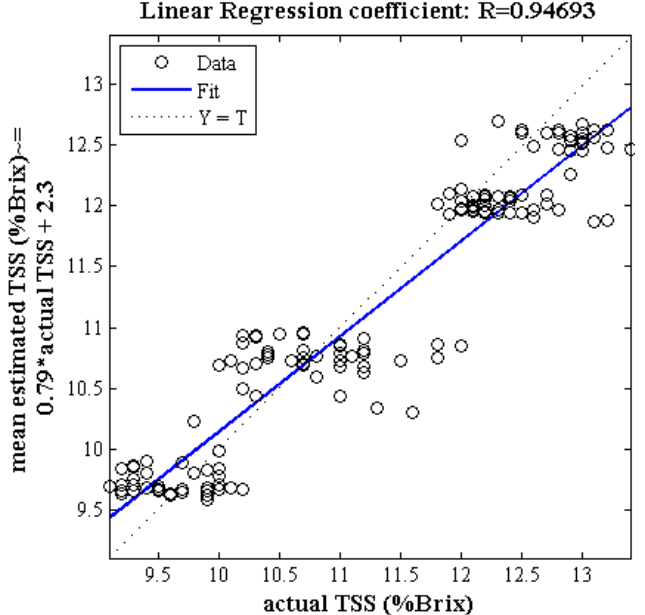
Figure 9. Regression analysis of the scatter plot between the estimated mean and the measured TSS content in Fuji apple based on the most e ff ective wavelength’s spectral